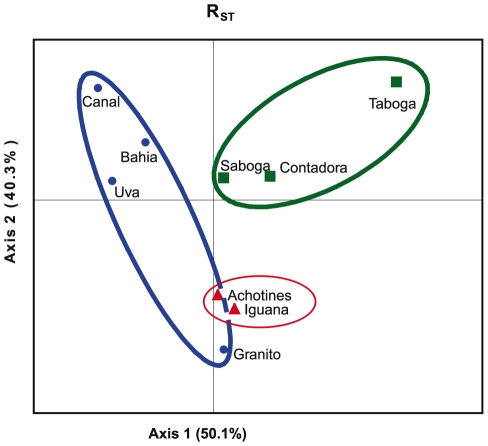
Principal component analysis of Pocillopora damicornis populations, constructed using GenAlEx 6.1 [130].Distances between populations were analyzed as RST pairwise genetic distances. The two axes explained 90.4% of the total variation. Blue circles  =  Populations in the Gulf of Chiriqui; Red triangles  =  Azuero Peninsula; Green squares  =  Gulf of Panama.